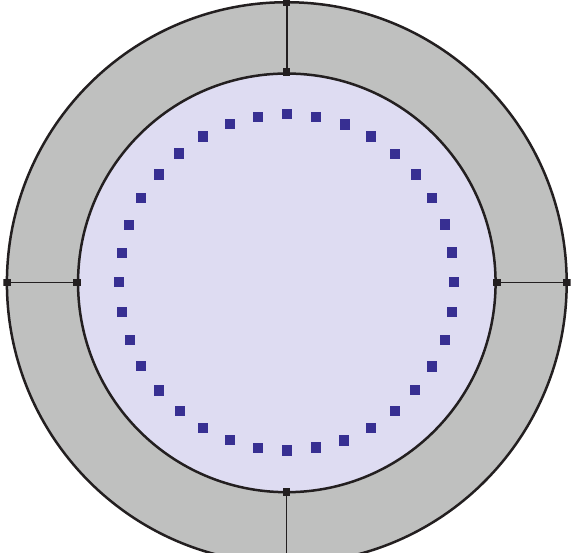
Figure 3: Acquisition setup on COMSOL :PML (grey), TX antenna positions (blue),. and matching medium (light